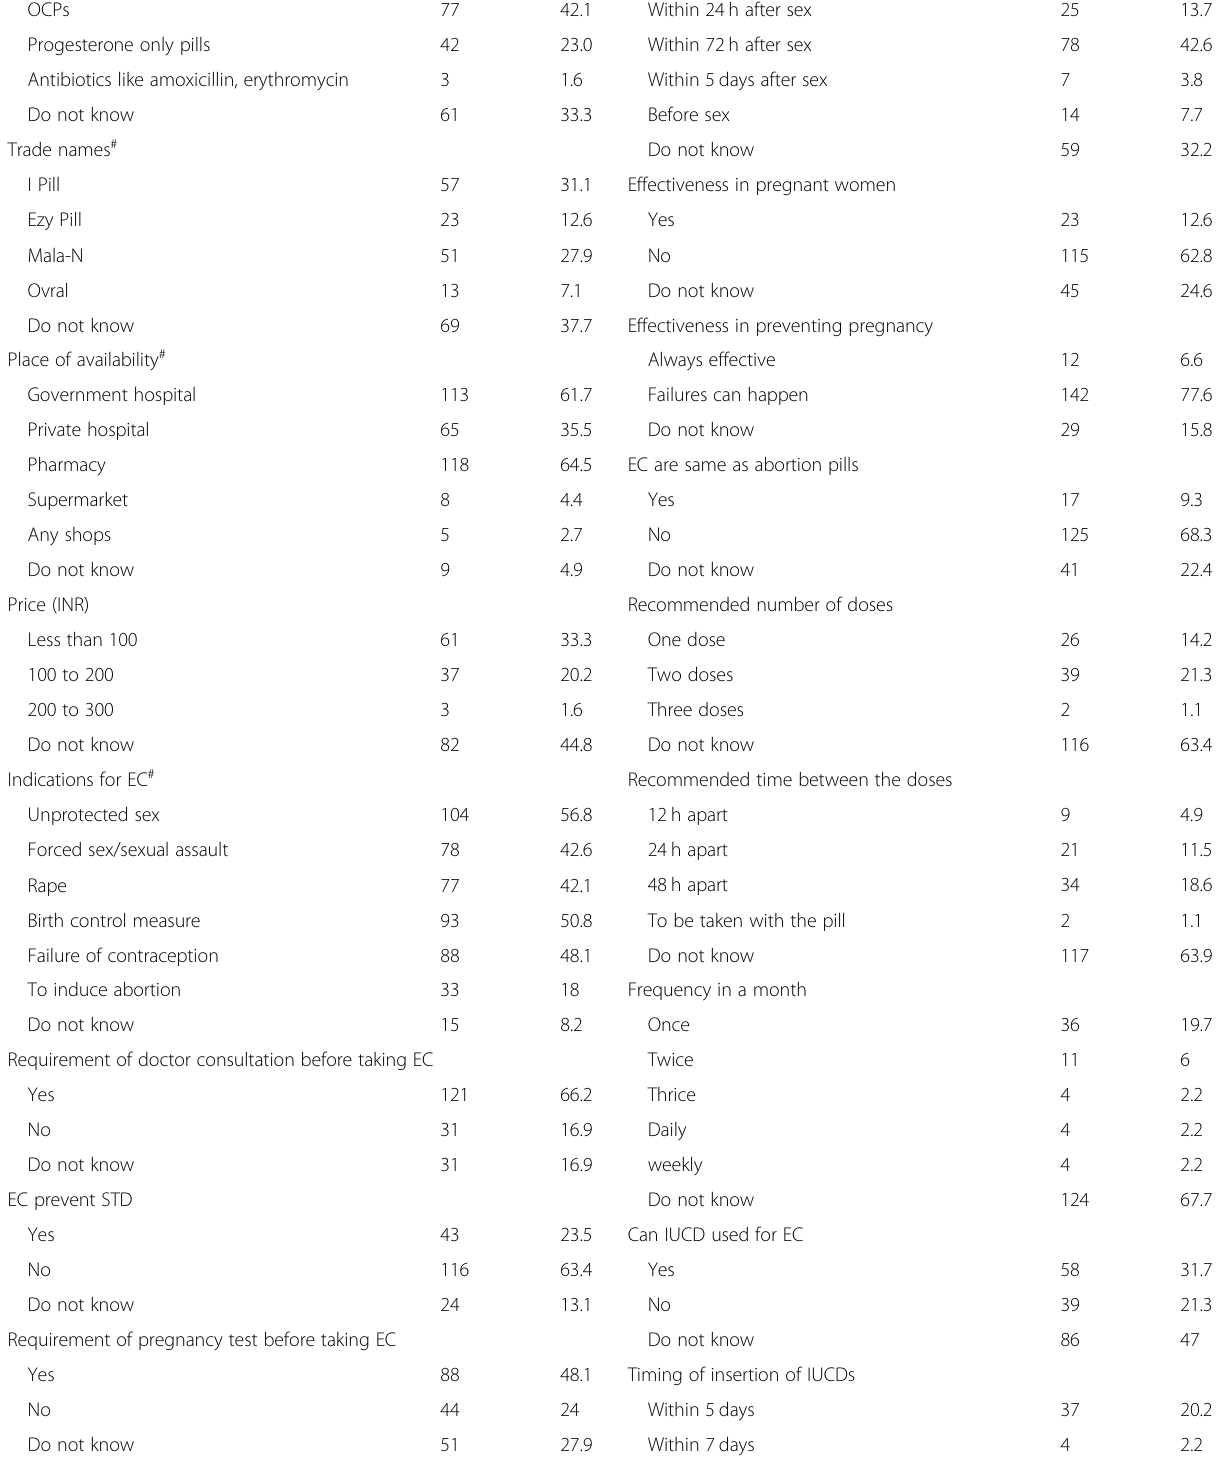
Table 2 Knowledge regarding the EC among the